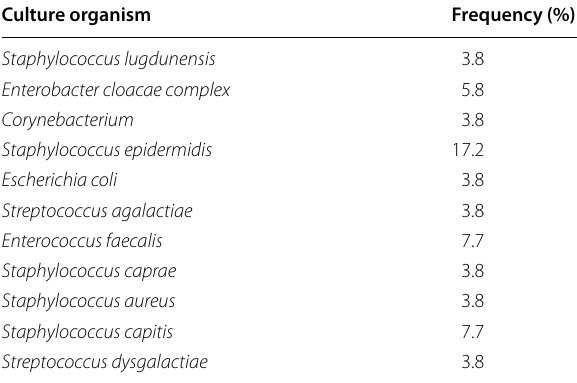
Table 2 List of the identified bacteria for the 25 patients the PJI